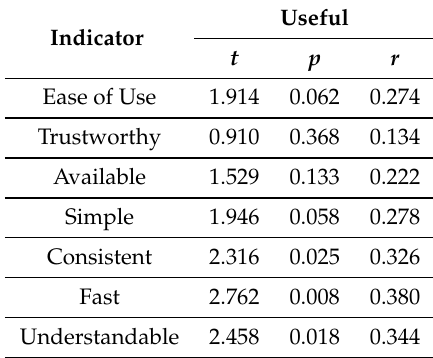
Table 6. Paired t -test between ‘useful’ and the other indicators: p refers to the statistical significance and r is the practical